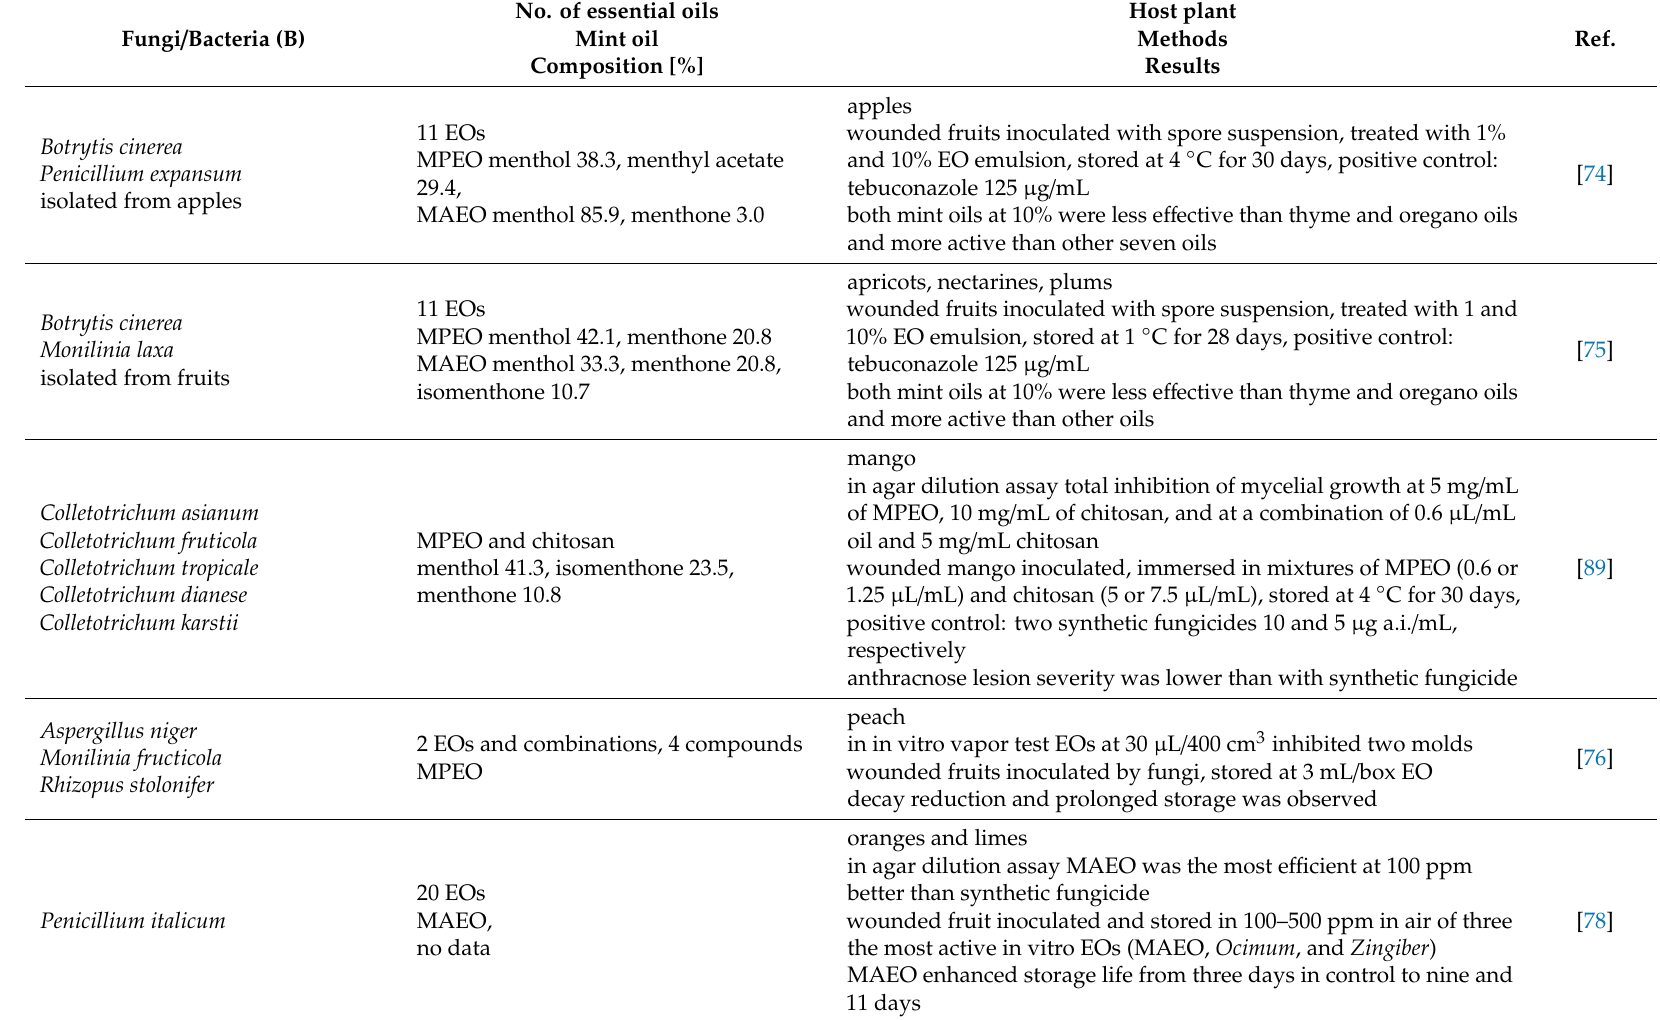
Table 2. In situ antifungal and antibacterial activity of peppermint and cornmint oil against